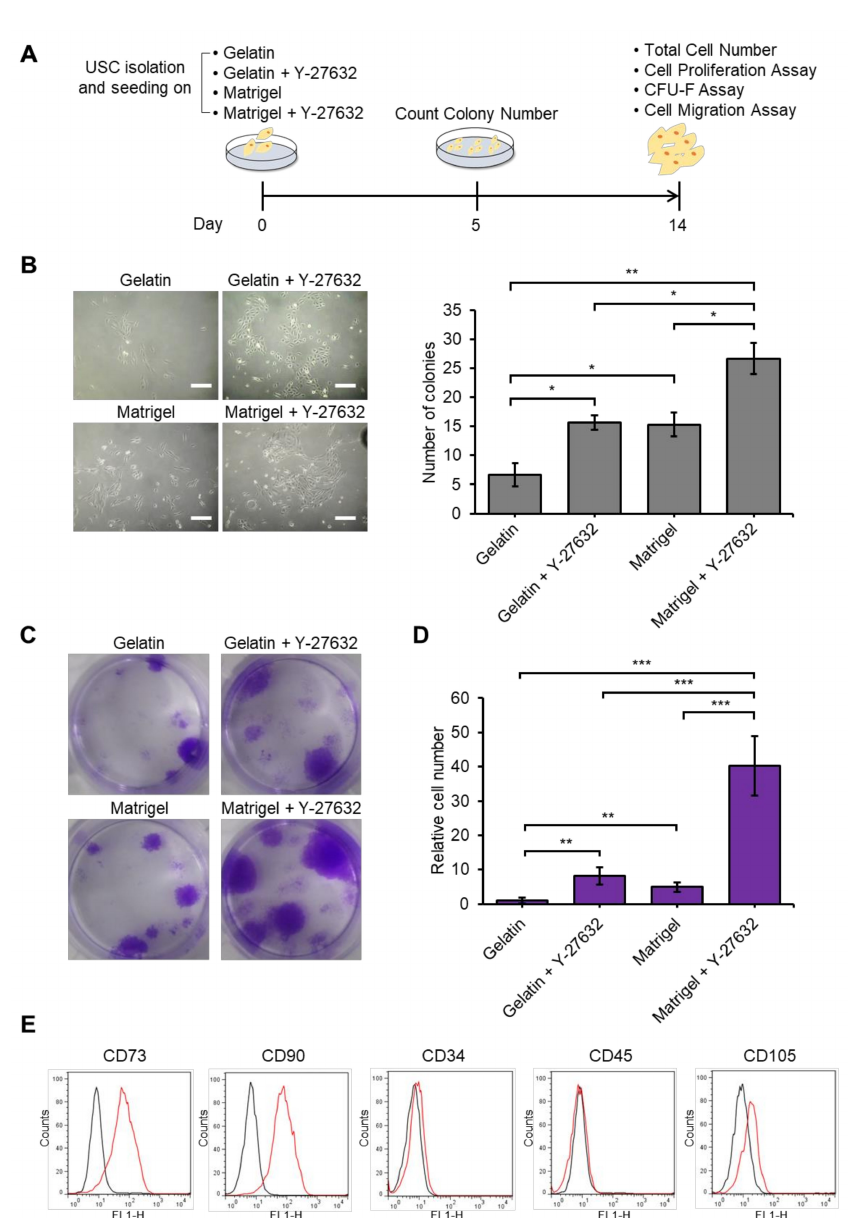
Figure 2. Y-27632 and Matrigel markedly increased the isolation e ffi ciency of USCs. ( A ) Schematic of the USC isolation method using gelatin, Y-27632, Matrigel. ( B ) Representative phase-contrast of USCs isolated using gelatin, gelatin + Y-27632, Matrigel, and Matrigel + Y-27632 (left panel). Number of USC (6 donor) colonies obtained using gelatin, gelatin + Y-27632, Matrigel, and Matrigel + Y-27632 (right panel) in the well of a 12 well culture plate. Scale bar: 200 µ m. ( C ) Images of USCs treated with gelatin, gelatin + Y-27632, Matrigel, and Matrigel + Y-27632 and stained with crystal violet after 14 days. ( D ) Relative cell number of isolated from USCs (6 donor) after 14 days deduced with the number of isolated cells in gelatin-only plate set to 1. Asterisks indicate significant di ff erences. ( E ) Flow cytometric analysis of USC surface marker expression on the USCs of Y-27632 + Matrigel group (black line: isotype control (Con), red line: USC specific marker). n = 3 biological samples. (* p < 0.05, ** p < 0.01, *** p <